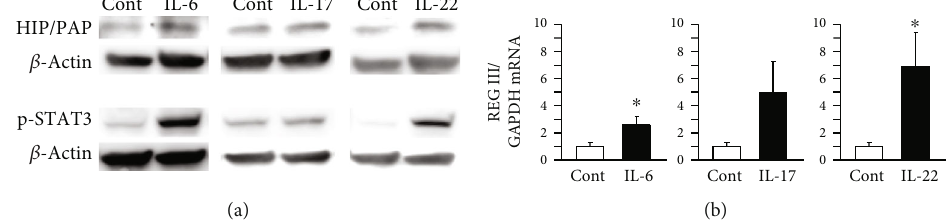
Figure 6: (a) E ff ect of cytokines on STAT3 phosphorylation and human HIP/PAP expression in HCT116 cells. HCT116 cells ( 2 × 10 5 ) were cultured in 6-well plates for 24 h and then treated with cytokines (IL-6, IL-17, and IL-22) at 100 ng/ml for 24h and 30 min to examine HIP/PAP expression and STAT3 phosphorylation, respectively. (b) E ff ect of cytokines on REG III expression. HCT116 cells were stimulated by cytokines at 100ng/ml for 24h ( n = 4 ). Results are expressed as the mean ± SE . Signi fi cantly greater than in controls: ∗ P < 0 : 05